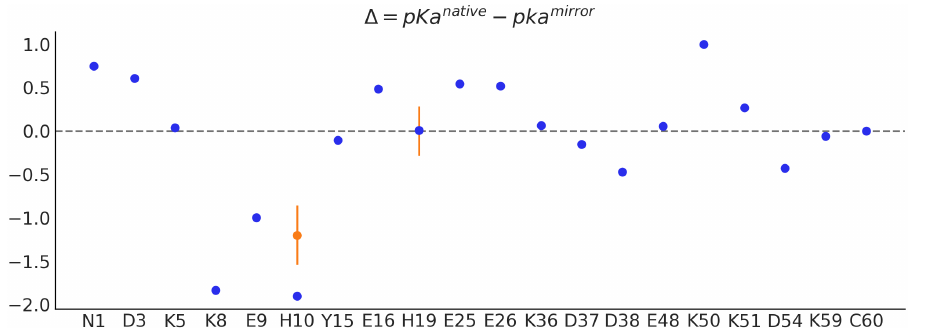
Figure 3 Dots indicate the pKa change ( (cid:49) ), computed at pH 7.0, for each ionizable residue along the protein Q10H sequence. The blue-dots were computed from the single lowest-energy generated confor- mations of both the native-like and mirror-image topology, respectively. The orange-dots were computed for the two histidines in the sequence, namely H10 and H19, as an average over 25 ns MD simulations for both the native-like and mirror-image conformations; vertical orange-lines denotes the standard devia- tions of the computed average (cid:49) values. Full-size DOI: